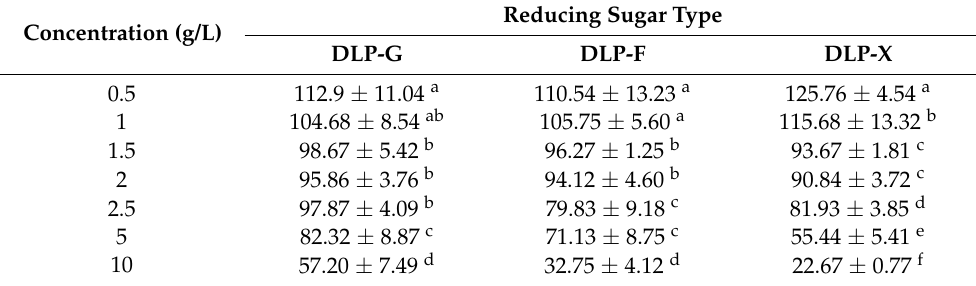
Table 1. Effect of duck liver protein glycosylation products concentration on the survival rate of HepG2